Question: Author a descriptive caption for the visualization shown.
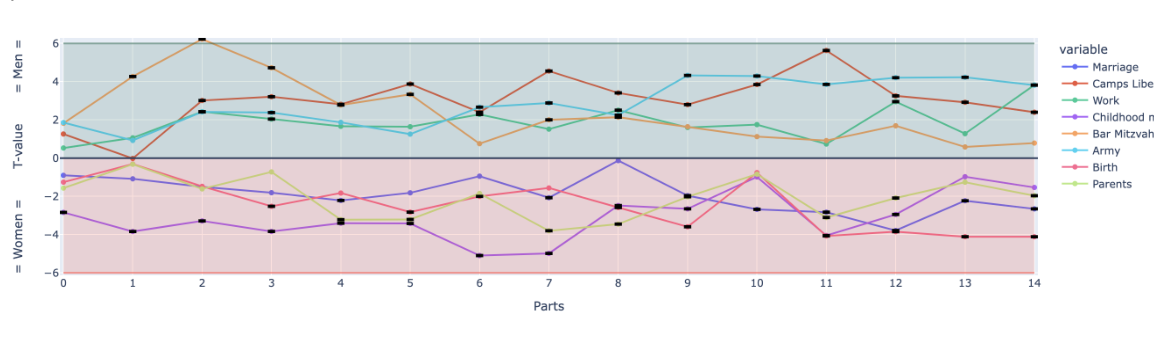
Answer: Men vs. women survivors typical testimony t-test. The Black Point represents values with p-values under 0.01.